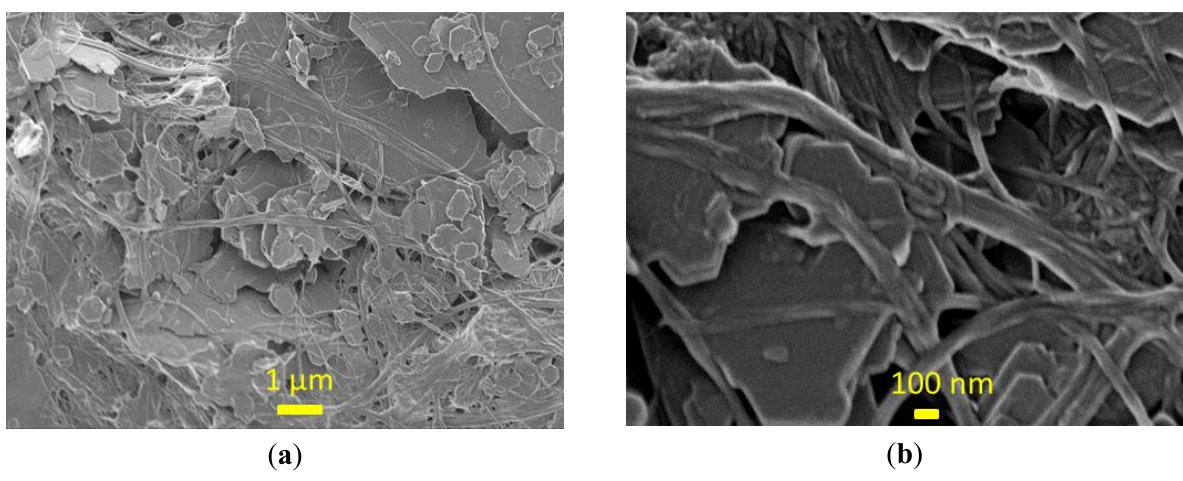
Figure 3. High resolution SEM images of the PCN sheet before calendering. The cellulose micro-“membranes” seen at a lower resolution between the kaolin pigment particles ( a ) are actually porous fibrillar networks in the nanoscale ( b